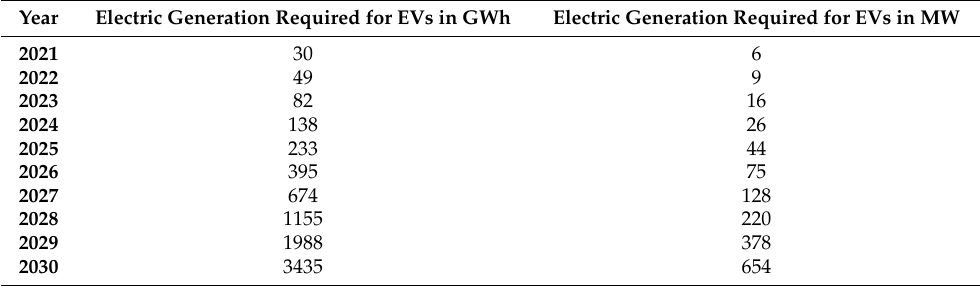
Table 5. Revised electricity generation for EVs: 2021–2030.